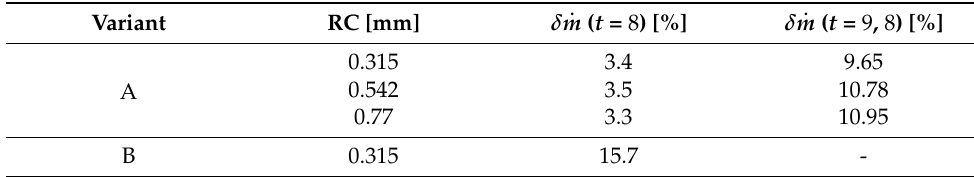
Table 8. Summary of change of the leakage rate by Equations (17) and (18) for application of the design method for Variant A and B, for the initial geometry (8t) and the improved one 8t and 9t, p in /p out = 2 T in = 300 K, p out = 10 5